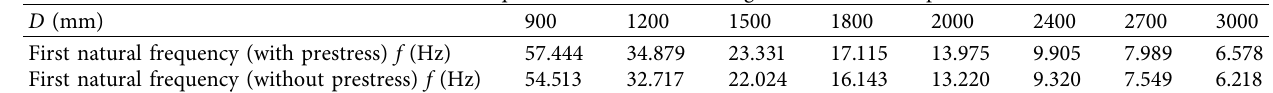
Figure 7: Flow forces on the impeller. (a) View from the front, (b) view from the side, and (c) view from the back. Table 7: First natural frequencies of the various length rotors with the prestresses.